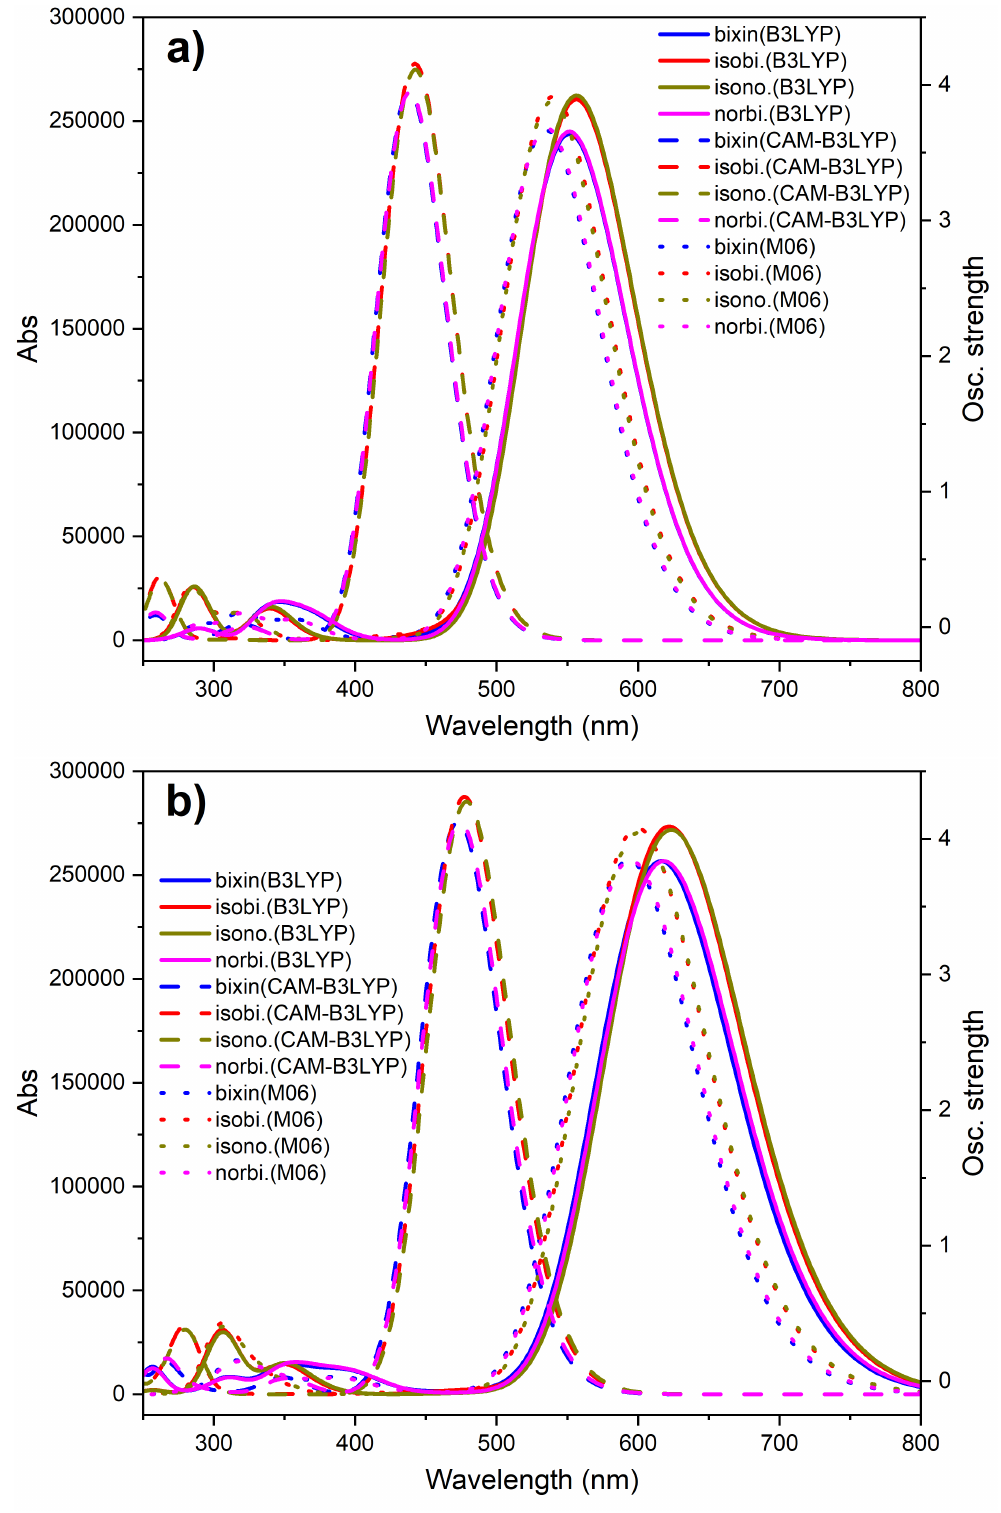
Figure 5. Absorption spectra of the molecular dyes in ( a ) gas phase and ( b ) chloroform solution. These results were obtained by employing the 6-31+G(d,p) basis